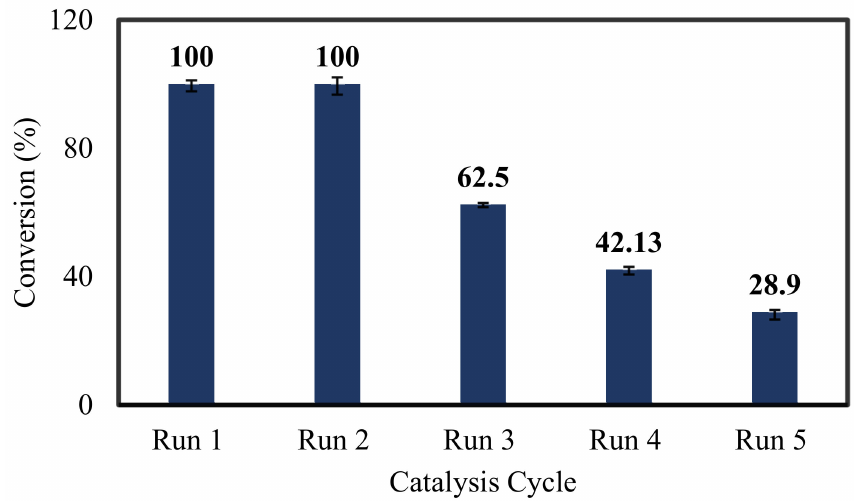
Figure 14. Catalyst recycling study of @PtCassCat catalyst. Reaction conditions: Furfural (10 mmol), base (Et 3 N) (10 mmol), formic acid (20 mmol), temperature (160 ◦ C), time (24